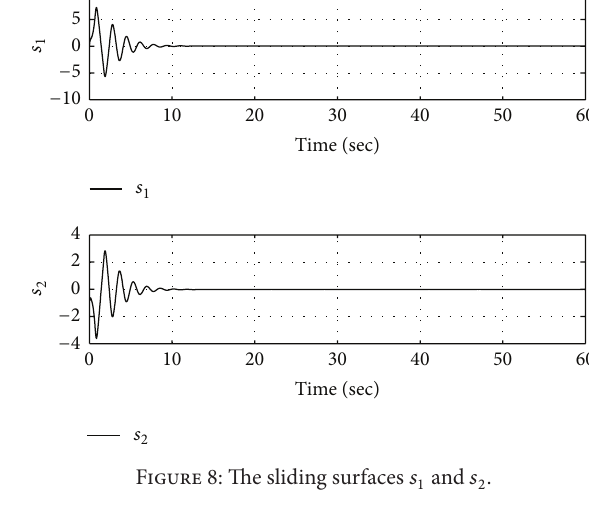
Figure 8: The sliding surfaces 𝑠 1 and 𝑠 2 .